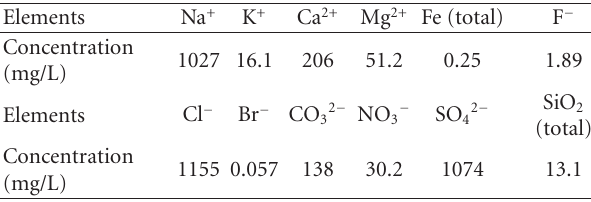
Table 2: The composition of Beishan underground